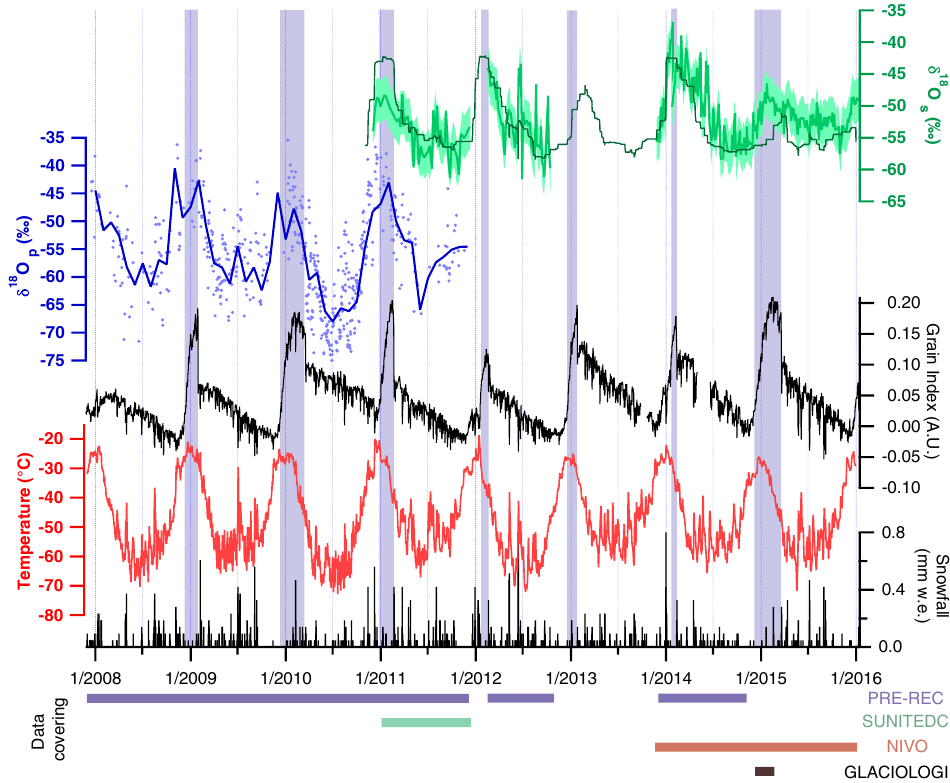
Figure 3. Monitoring of precipitation and surface snow at Dome C between 2008 and 2016 (for details, see Table 2). From top to bottom: surface snow isotopic composition ( δ 18 O s , light green lines); the light green shaded area is the uncertainty obtained from replicates (2 σ , see Sect. 3.1.2); the dark green line is the modelled surface snow isotopic composition from the toy model detailed in Sect. 3.2; isotopic composition of precipitation ( δ 18 O p , blue, dots: raw data, line: monthly average); grain indices from satellite observations (black fine line, Picard et al., 2012), 2m temperature measurements (red line) and precipitation (black bars) from ERA-Interim reanalysis product. The blue shaded bars indicate periods of high grain index (arbitrary threshold on the variations indicating when metamorphism is